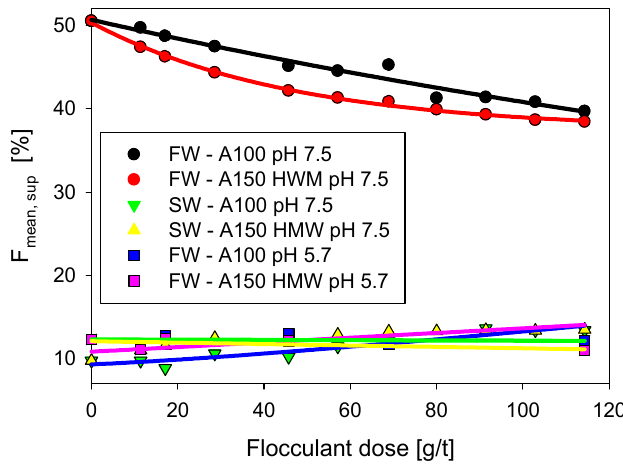
Figure 7. Signal values of F mean (%) for supernatant liquid of kaolin suspensions 7 wt. % flocculated with A150 HMW or A100 in three conditions: (i) Distilled water (NaCl 0.01 M) at pH 7.5, (ii) seawater at pH 7.5, and (iii) distilled water (NaCl 0.01 M) at pH 5.7.